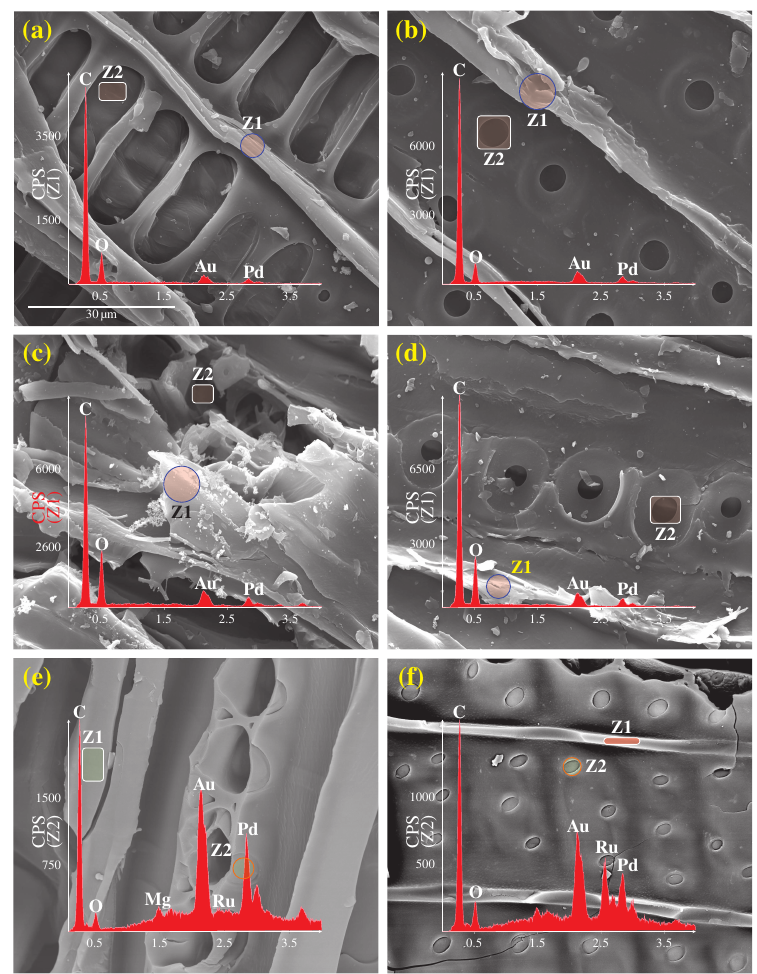
Figure 3. EDX spectra and photographs of secondary electrons (SEM) for samples ( a , b ): “BC”, ( c , d ): “OBC”; Back-scattered electrons (BSE) for samples ( e ): “Ru-BC”, ( f ): “Ru-OBC” (scale of